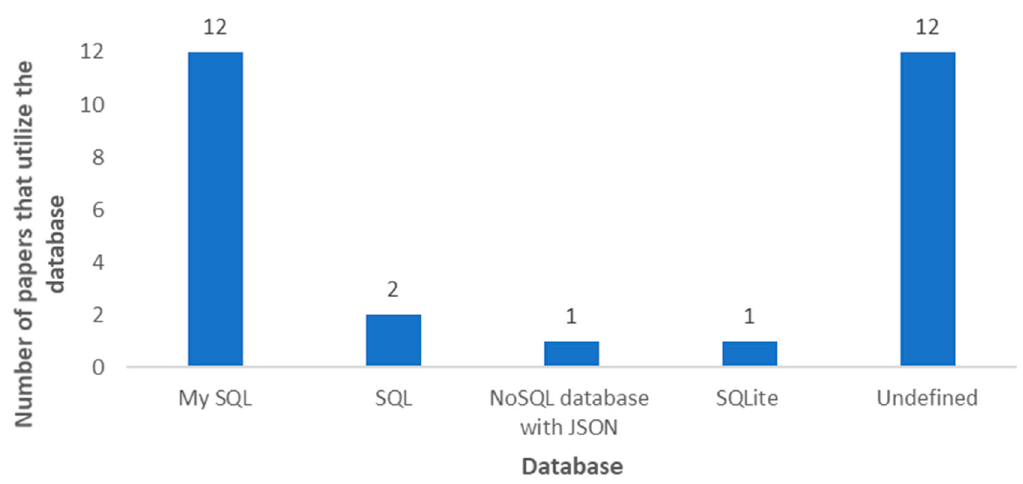
Figure 28. Number of employed Databases to store data of IoT nodes for irrigation systems.